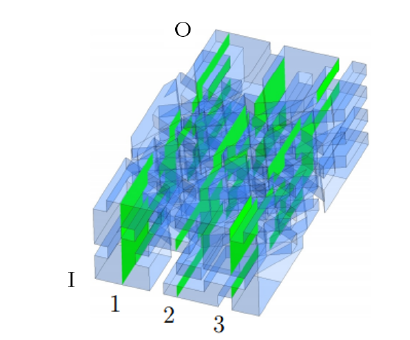
Figure 11. Cutting